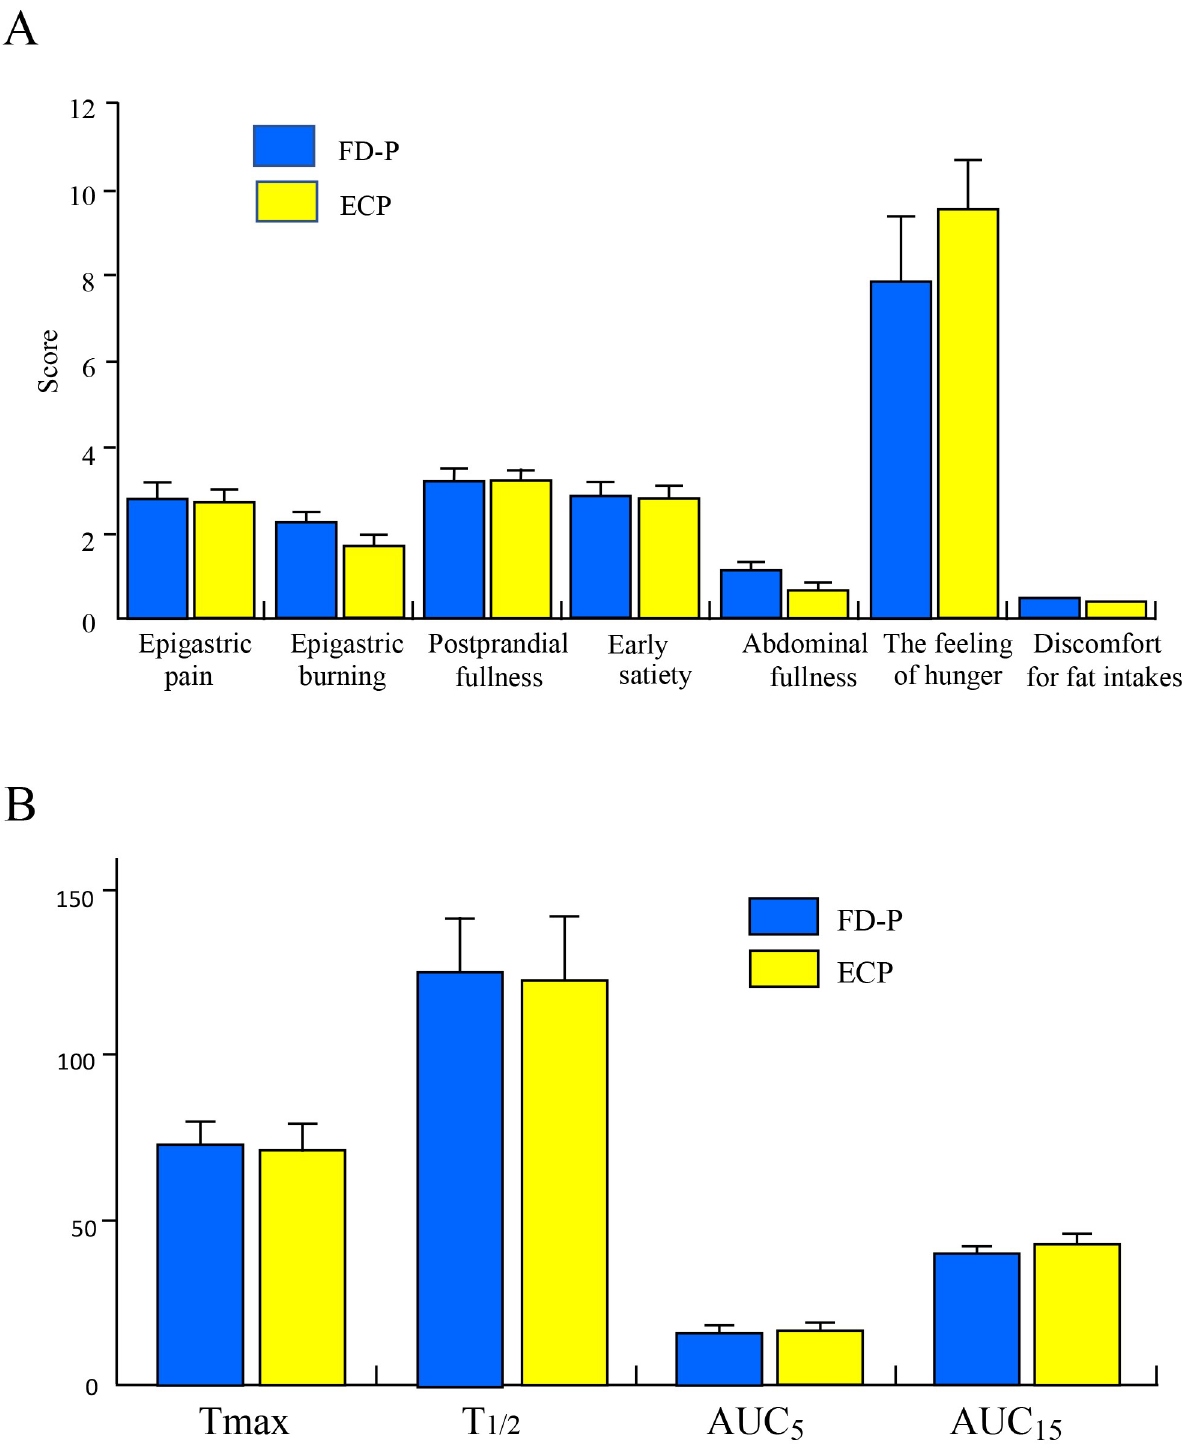
Fig 1. Comparison of bothersome FD symptoms and clinical symptoms between ECP and FD-P patients. 1A. There were not significant differences in epigastric pain, epigastric burning, postprandial fullness, early satiety, abdominal fullness, the feeling of hunger and discomfort for fat intakes between ECP and FD-P patients. 1B. Comparison of gastric motility between ECP and FD-P patients. There were no significant differences in Tmax and T1/2 values between early chronic pancreatitis (ECP) and FD patients with pancreatic enzyme abnormalities (FD-P).